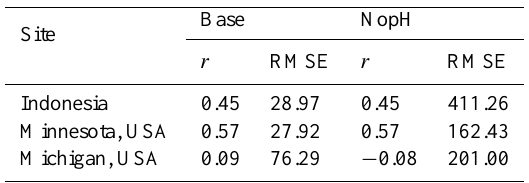
Table 3. Model performance statistics for the Base and NopH sim- ulations at selected wetland